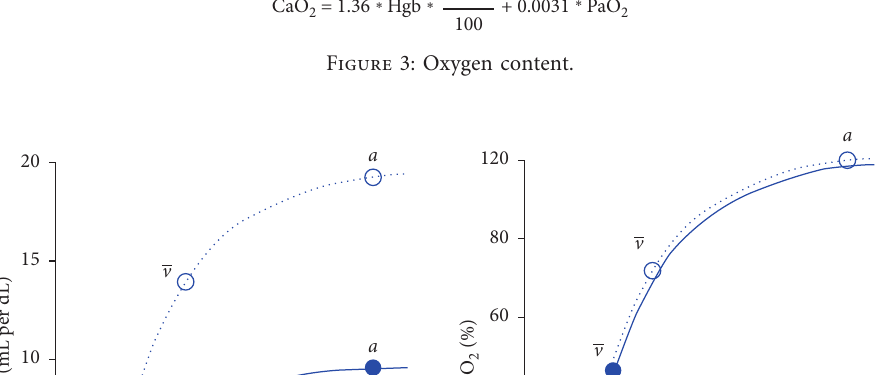
Figure 3: Oxygen content.